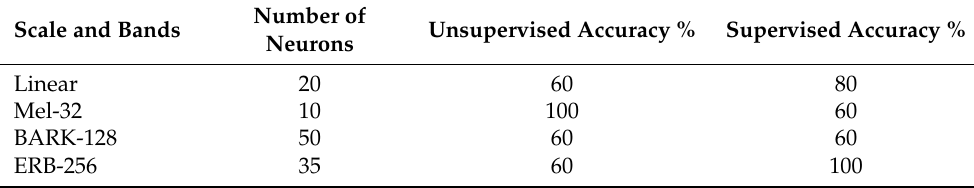
Table 4. Best accuracy results for different scales and number of bands.